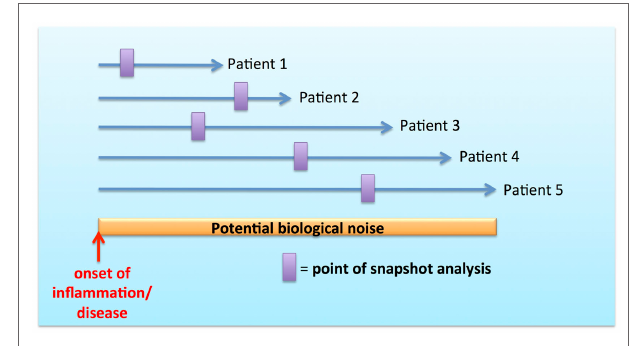
FiGURe 2 | Biological noise with snapshot analysis during temporal course of inflammation and disease .